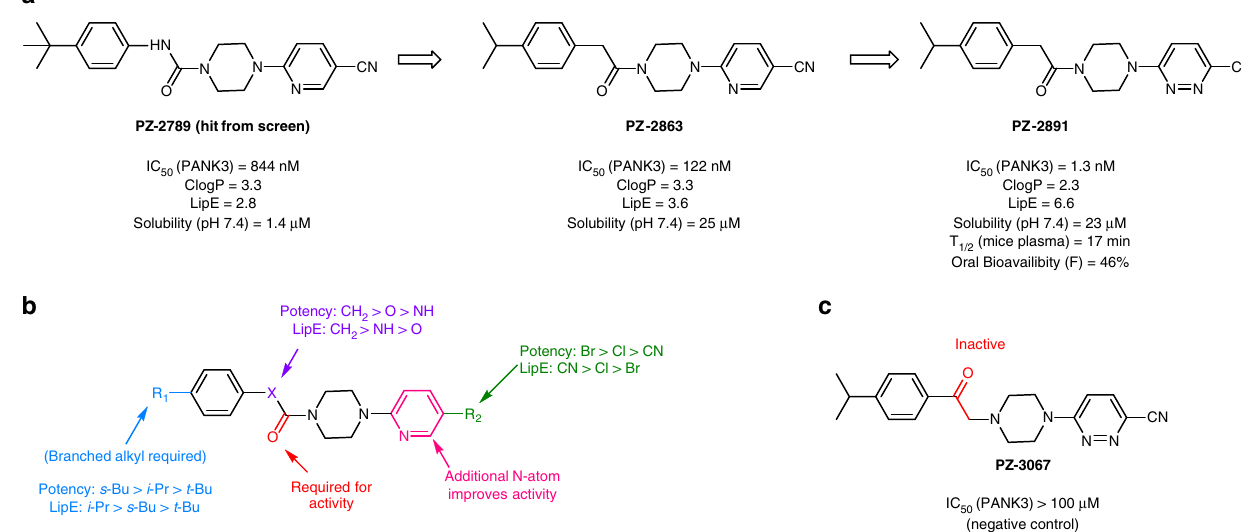
Fig. 1 Chemical progression of pantazines. a Lipophilic ligand ef fi ciency (LipE = pIC 50 – clogP) guided optimization of the pantazine series from the initial hit (PZ-2789) to PZ-2891. b Summary of the structure-activity relationships of >60 compounds synthesized during the optimization of the pantazine scaffold. c Chemical structure of an inactive pantazine, PZ-3067, which is used as a negative control in cellular